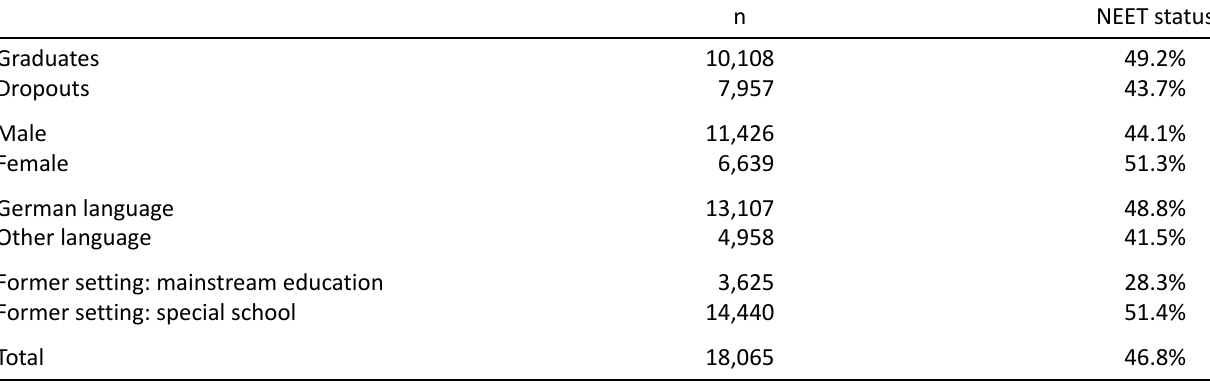
Table 2. Transition routes into NEET status according to different